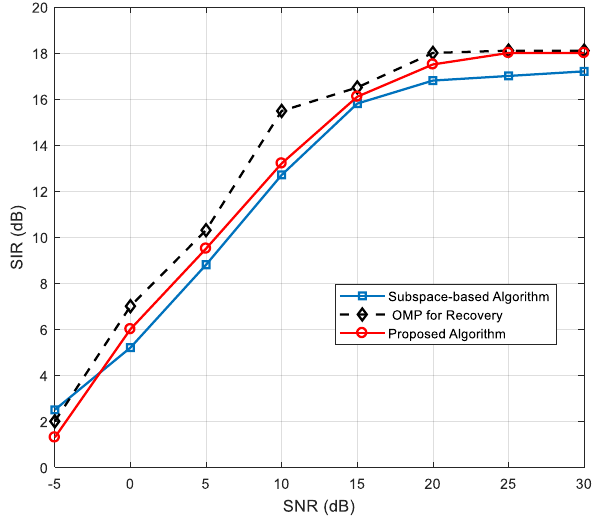
Figure 8. Performance comparison against SNR.